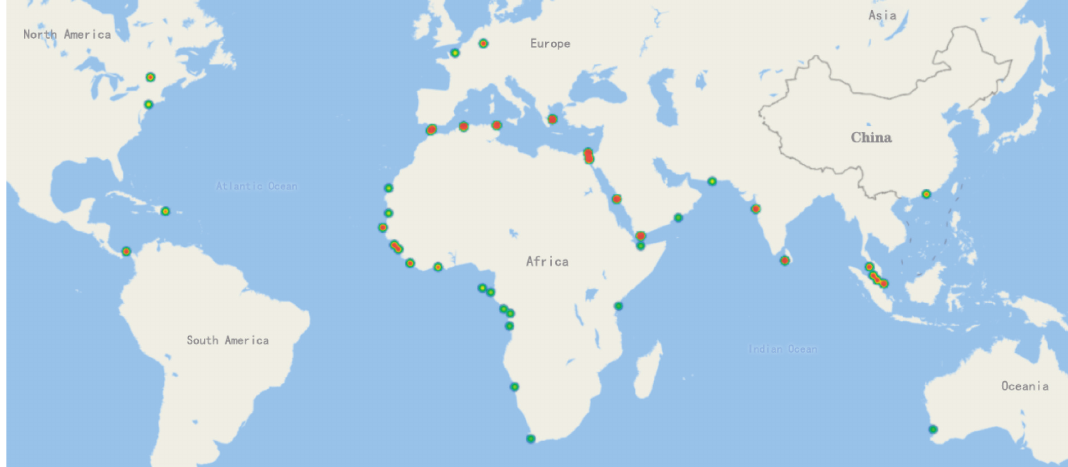
Figure 2: The thermodynamic diagram about rank in the top 41 of the number of ports crossed by the shortest